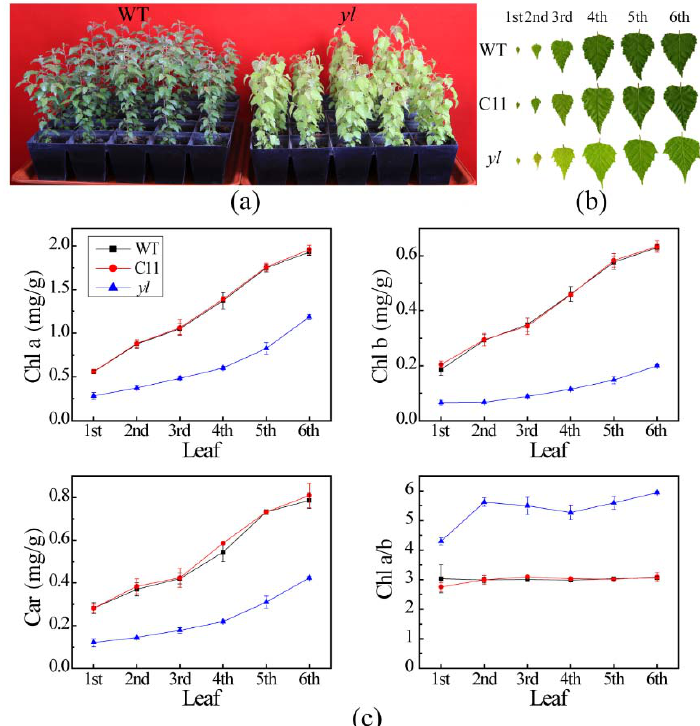
Figure 1. Growth performance and pigment content of wild type birch (WT), BpCCR1 overexpression line 11 (C11) and yellow-green leaf mutant ( yl ) lines. ( a ) Growth performance of one-year-old WT and yl plants. ( b ) The leaves from first to sixth of WT, C11, and yl lines. ( c ) Chl a, Chl b, Car, and Chl a/b in first to sixth leaves of WT, C11, and yl lines. Error bars represent the standard deviation (SD) of three independent experiments.